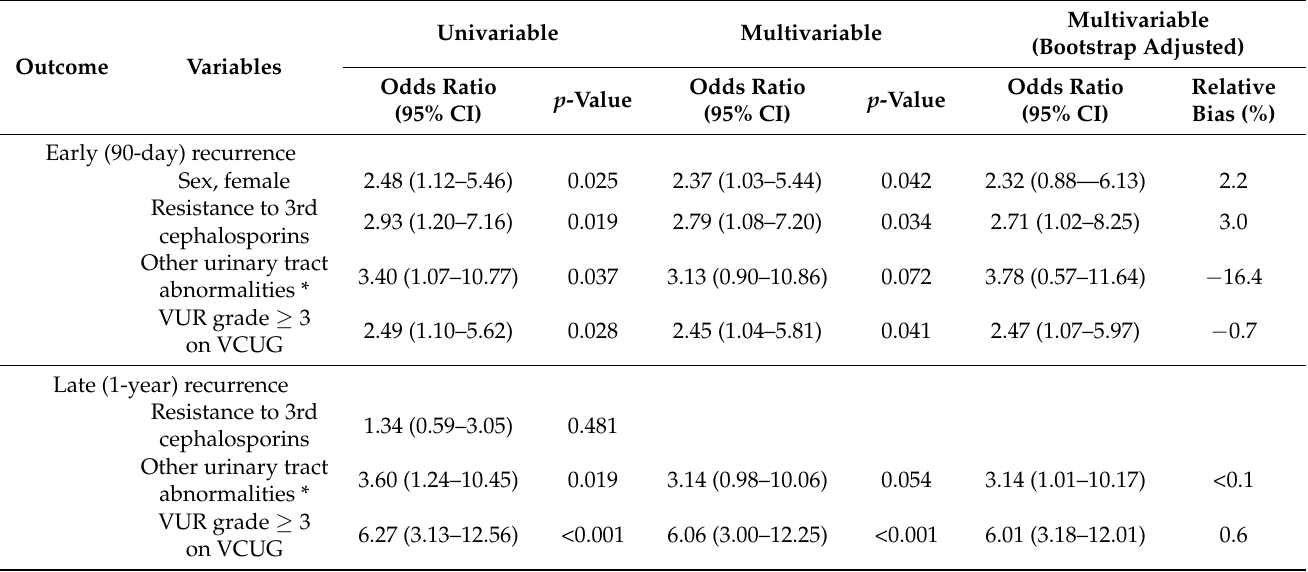
Table 2. Risk factors for early and late recurrence of UTI.